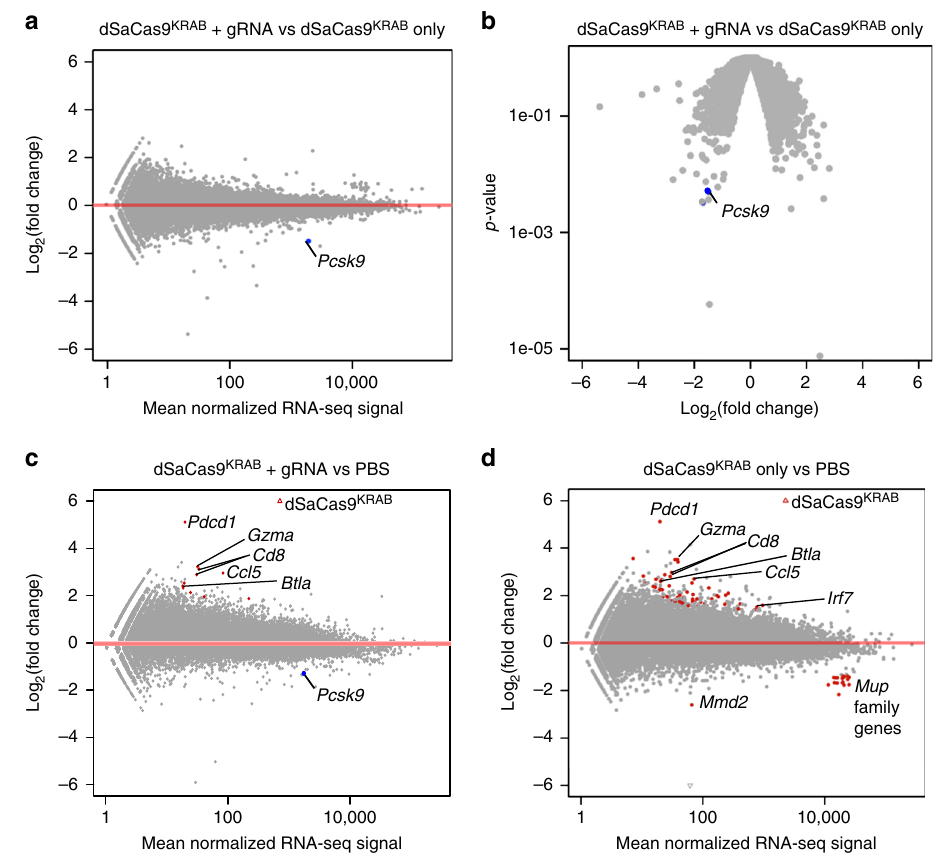
Fig. 3 Genome-wide analysis of gene expression in dSaCas9 KRAB -treated mice. a – d RNA-sequencing and differential expression analysis was performed comparing liver tissue from mice treated with a , b AAVs expressing dSaCas9 KRAB and Pcsk9 -targeting gRNA vs. dSaCas9 KRAB alone, c AAVs expressing dSaCas9 KRAB with Pcsk9 -targeting gRNA to PBS, or d AAV expressing dSaCas9 KRAB vs. PBS. Red data points indicate FDR < 0.05 by differential-expression analysis with a negative binomial generalized linear model and Wald test for signi fi cance 52 ( n = 4, mice 6 – 8 weeks old at time of treatment). The data point representing the Pcsk9 transcript is highlighted in blue (FDR > 0.05). Extended gene lists found in Supplementary Data 1, 4,